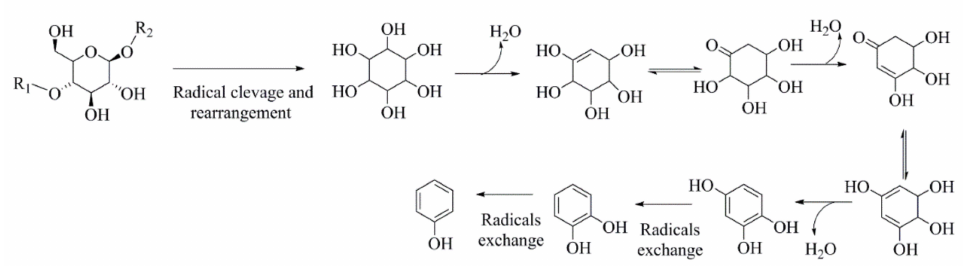
Figure 2. Chemical pathway of aromatics formation during MAP of cellulose as reported by Bar- toli et al.